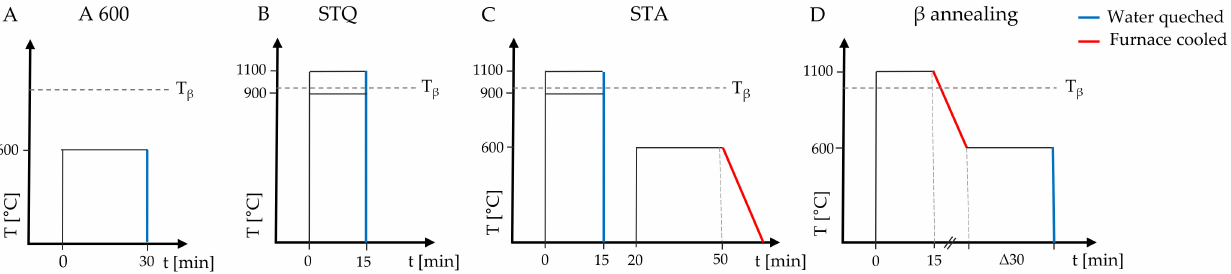
Figure 1. Schematic temperature (T)–time (t) diagrams of the performed heat treatments on the initial TiAl6V4 wrought condition: ( A ) annealing (A 600), ( B ) solution-treated quenched (STQ), ( C ) solution-treated annealed (STA) and ( D ) β annealing. Solution treatment was made above and below the β transus temperature for TiAl6V4 alloy (T β , indicated by a dashed grey